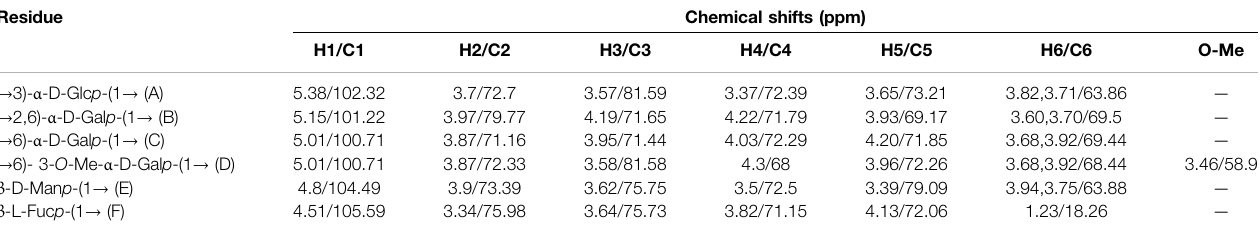
TABLE 2 | Assignments of 1 H and 13 C chemical shifts of sugar residues in PPp-W.